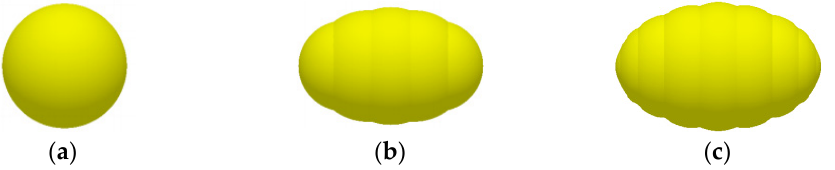
Figure 3. Classification of mini-tuber seeds: ( a ) class of spherical; ( b ) small ellipsoid; ( c ) large ellipsoid. Reprinted with permission from ref. [30]. Copyright 2018 China Agricultural University. Figure 4. Discrete element model of mini-tuber seed: ( a ) class of spherical; ( b ) small ellipsoid; ( c ) large ellipsoid. Reprinted with permission from ref. [30]. Copyright 2018 China Agricultural University.